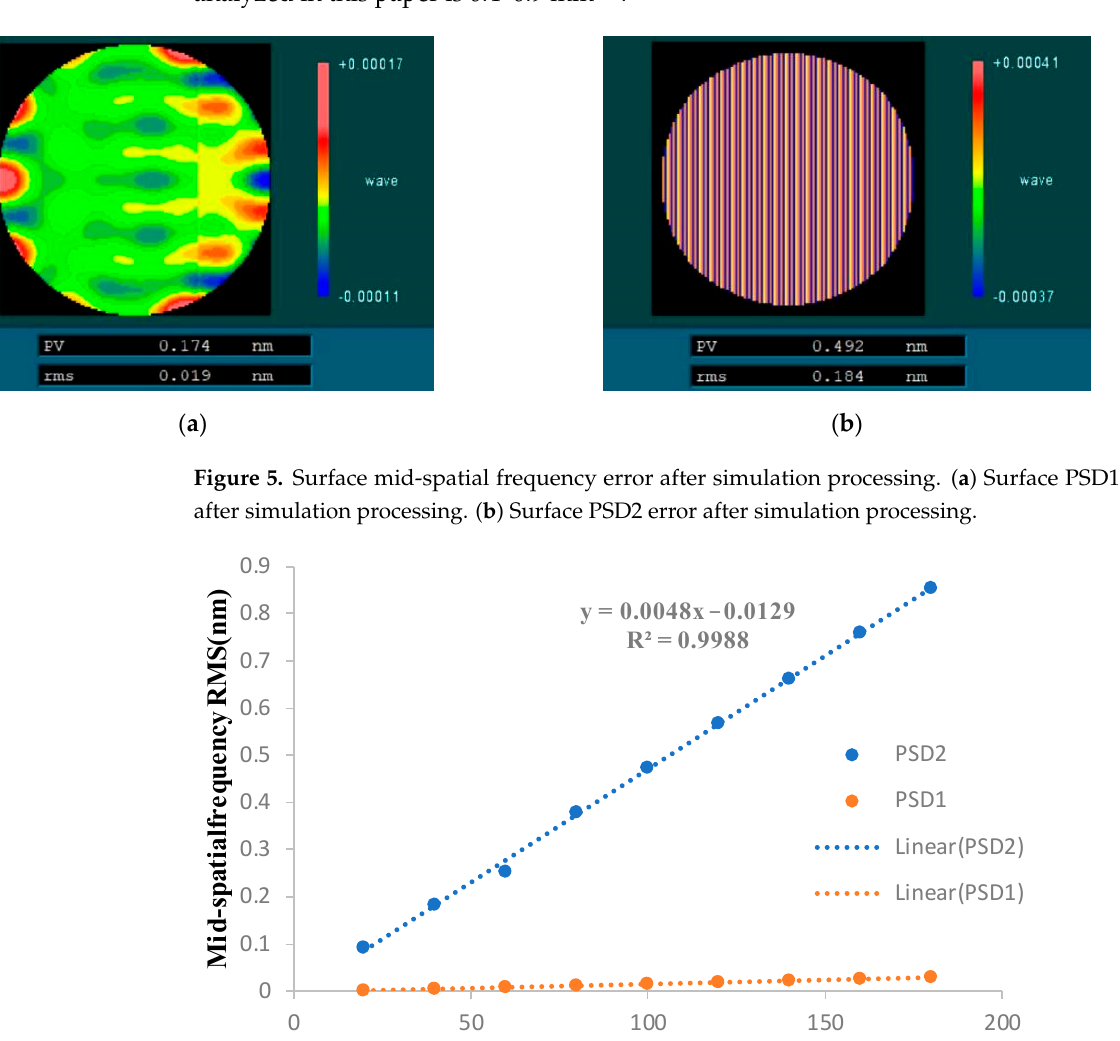
6 of 19 Figure 4. Relationship between average immersion depth and volumetric removal efficiency.